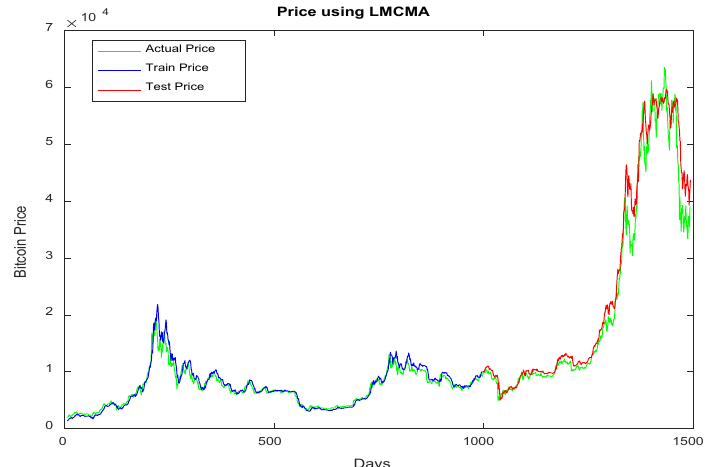
Figure 3. Bitcoin prices using LMCMA for BTC/USD dataset.